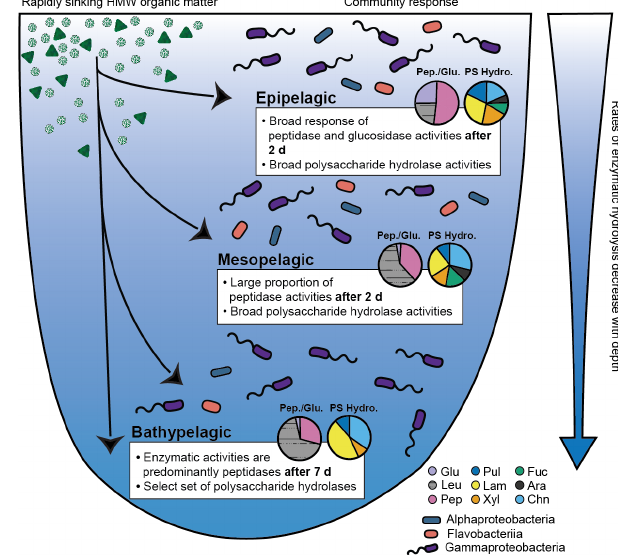
Figure 5. Conceptual figure illustrates the response of bacterial communities in North Atlantic epipelagic, mesopelagic, and bathy- pelagic waters to an input of rapidly sinking, fresh, HMW or- ganic matter. Community responses depicted here are the time point at which significant responses to the input of HMW or- ganic matter was measured (2d in epipelagic and mesopelagic incubations and 7d in bathypelagic incubations); polysaccharide hydrolase activities are an average of all time points. Pie charts show the relative contributions of peptidases and glucosidases (la- beled as Pep./Glu.) and polysaccharide hydrolases (labeled as PS Hydro.). Glu: α - and β -glucosidases, Leu: leucine